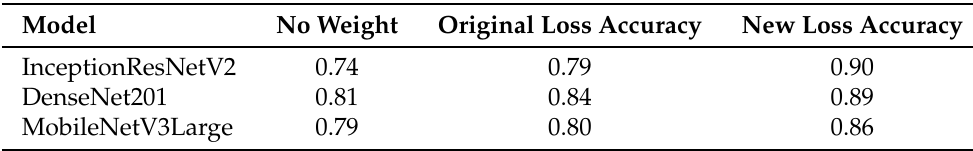
Table 8. Loss-based model accuracy